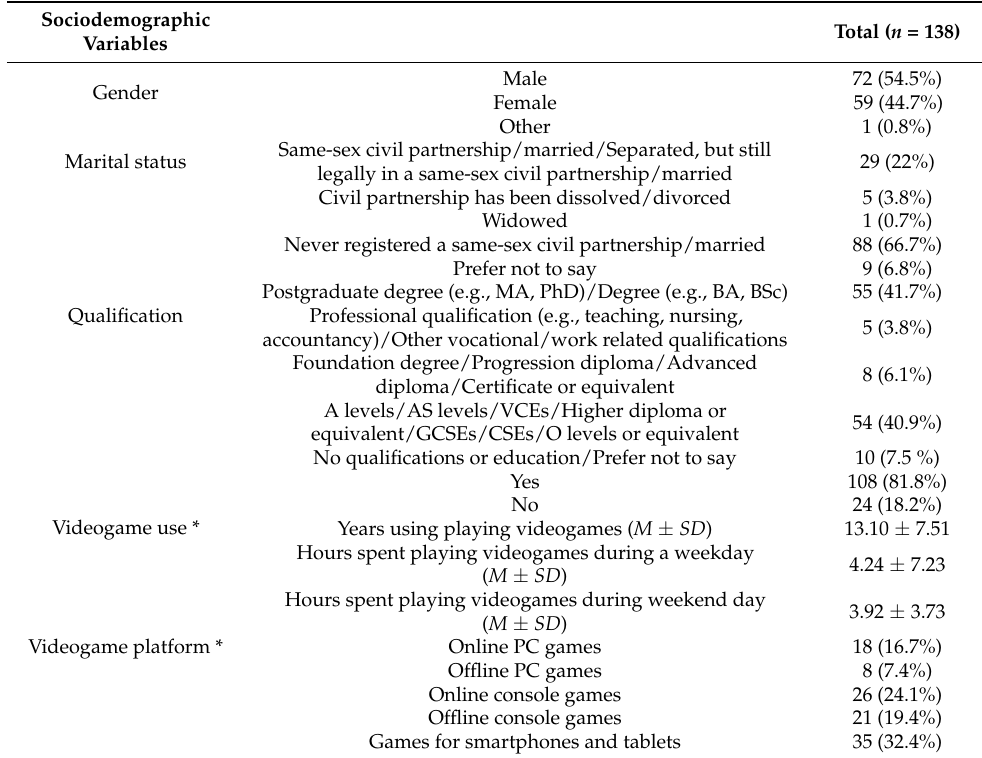
Table 3. Demographics and videogame use information (control